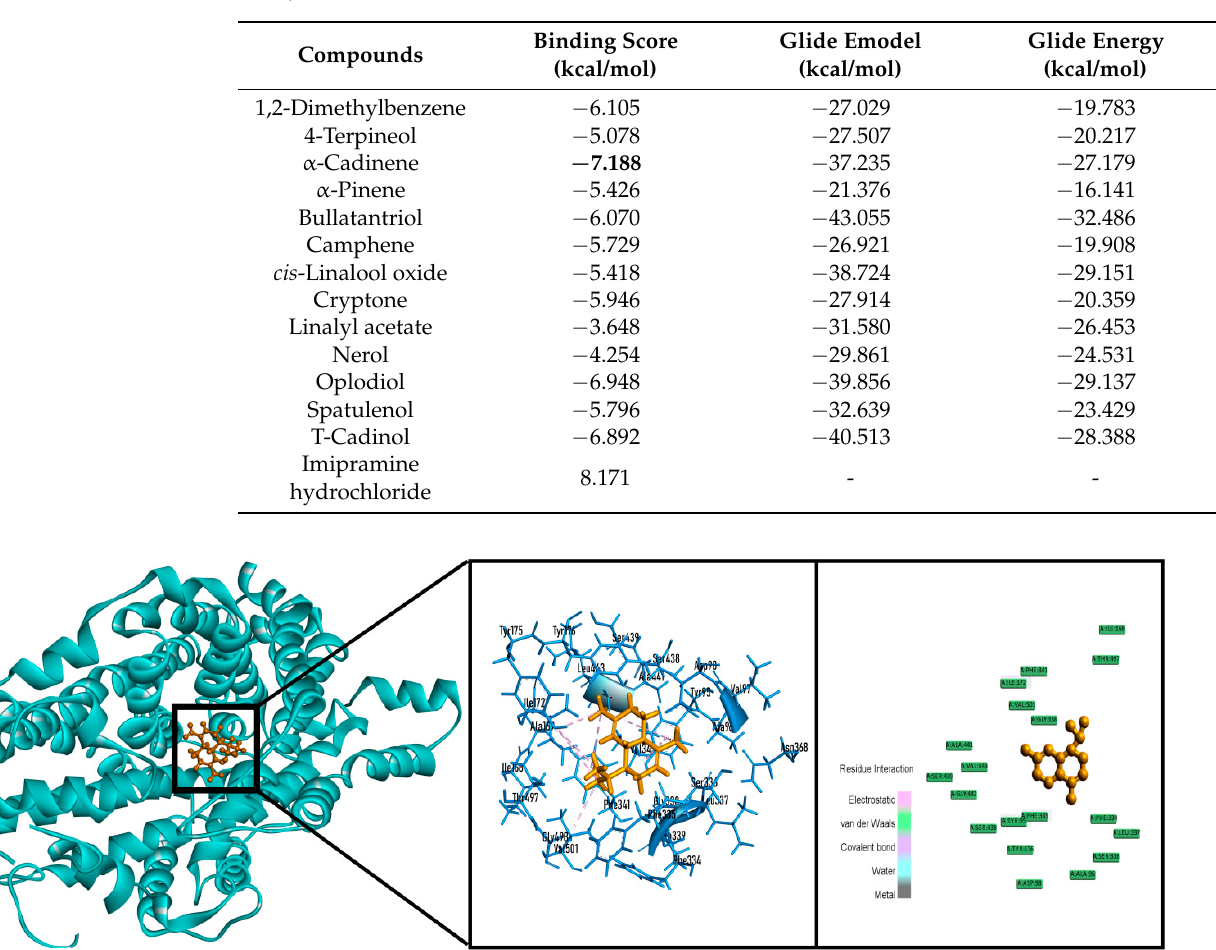
Table 5. Docking score of the phytochemical compounds of essential oil in leaves of H. aromatica with human serotonin receptor (PDB: 5I6X) for antidepressant activity (bold indicates lower docking score).